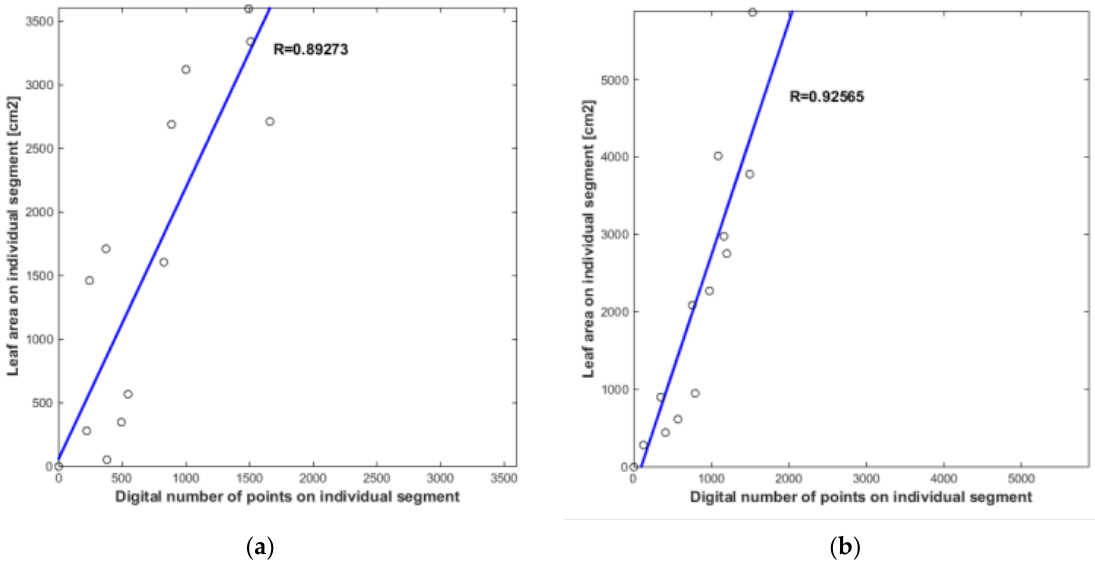
Figure 13. Correlation between number of points in segment (lidar measurements) and leaf area in